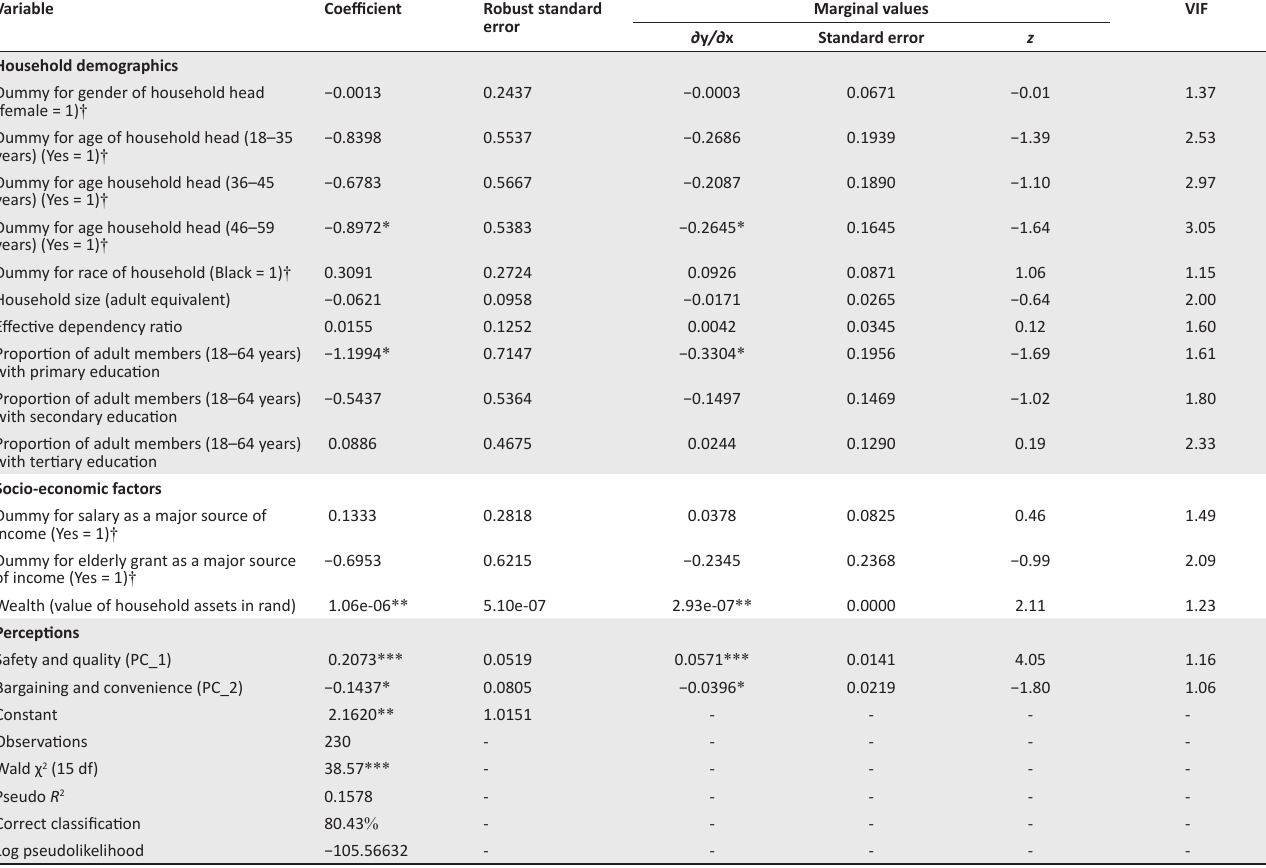
Variable Coefficient Robust standard